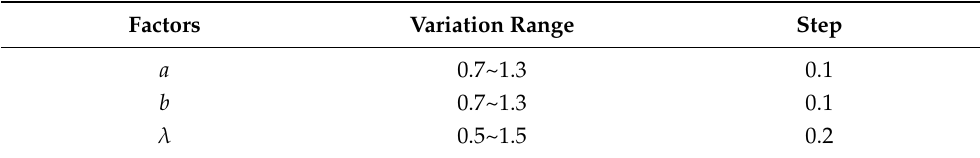
Table 1. Factor levels of the single factor test.